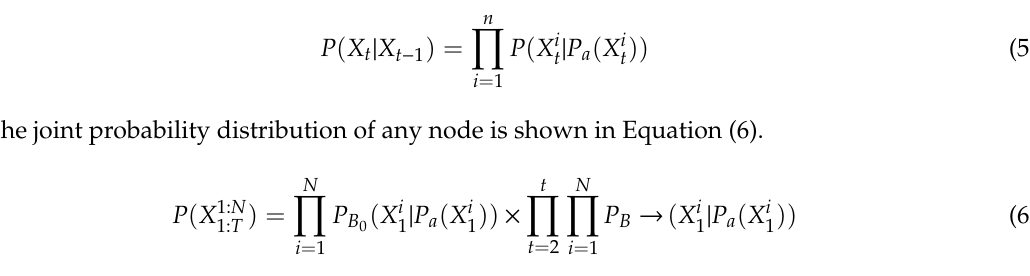
is the i node in the t time step; is the parent node and N is the number of random variables.